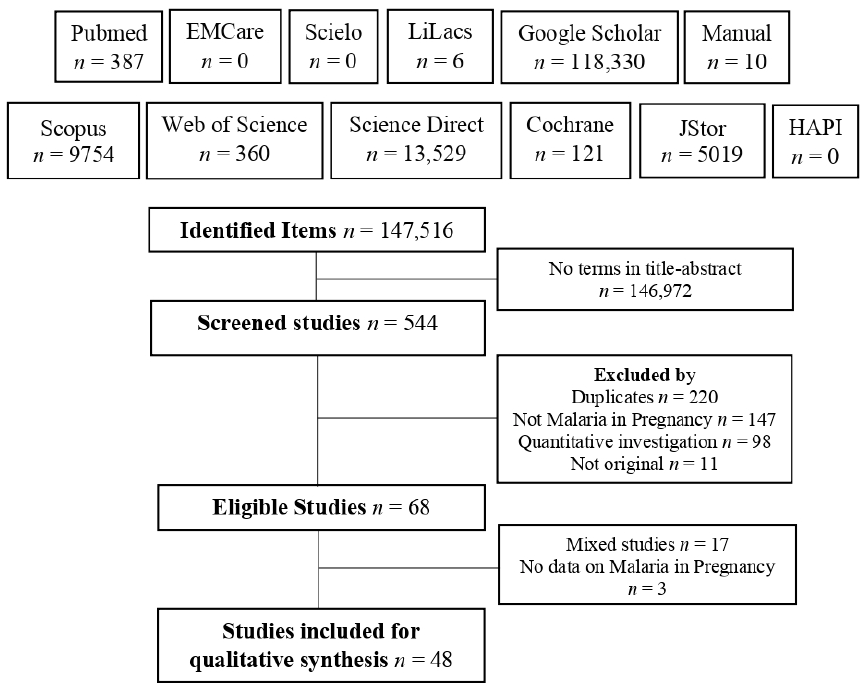
Figure 1. Flowchart of search and selection of studies.